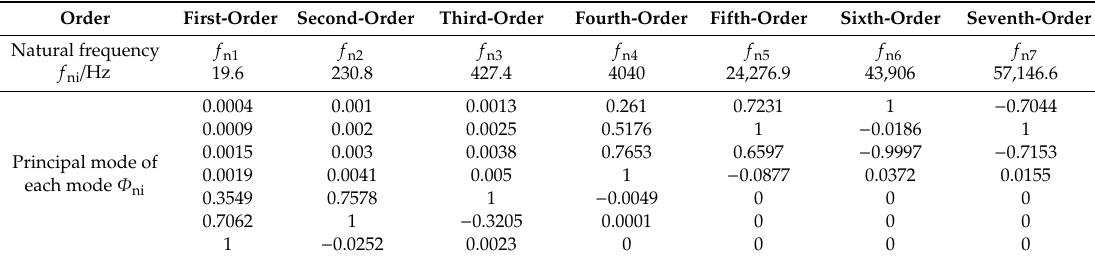
Table 3. Natural frequencies and mode shapes of the jet